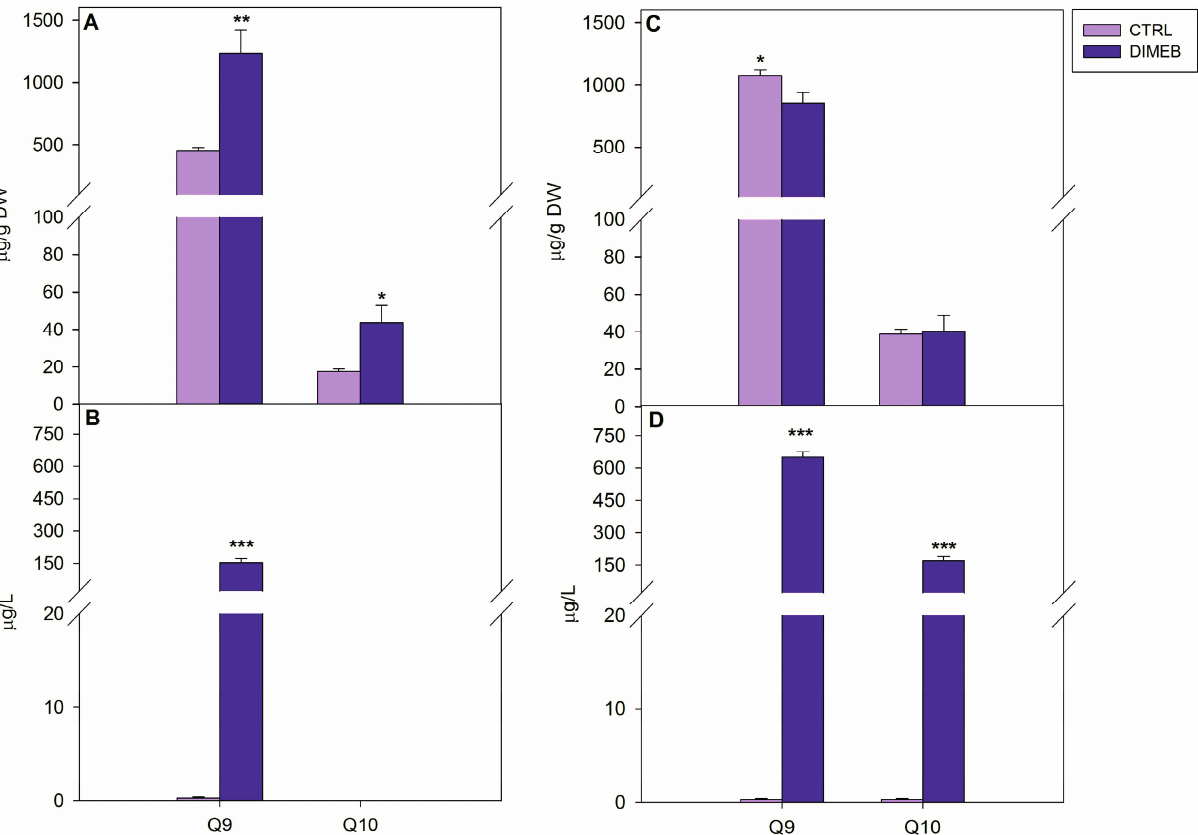
Figure 2. Intracellular and extracellular quinone levels in A. annua cell cultures untreated (CTRL) or treated (DIMEB) with 50 mM DIMEB. Data are expressed as mean ± standard deviation from three independent experiments, * p < 0.05; ** p < 0.01; *** p < 0.001 in comparison with control assessed by Anova-one-way post hoc Holm-Sidak test. Intracellular ( A ) and extracellular ( B ) quinone levels after three days of treatment; intracellular ( C ) and extracellular ( D ) quinone levels after seven days of